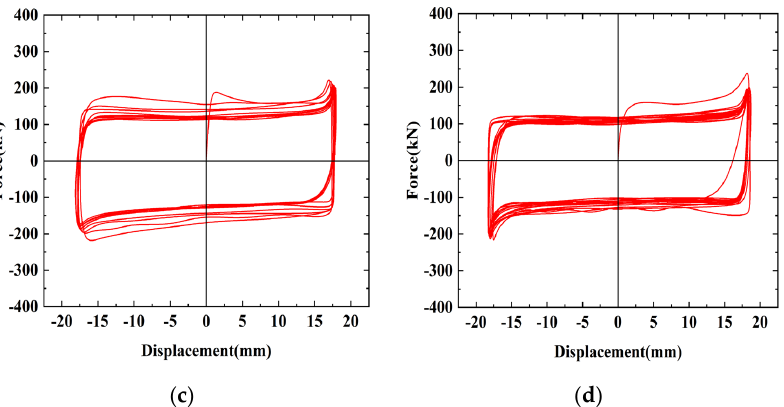
Figure 10. The hysteresis curves of different friction surfaces: ( a ) SJ1, brass; ( b ) SJ4, aluminum; ( c ) SJ5, no friction plates; ( d ) SJ6, shot blasting.